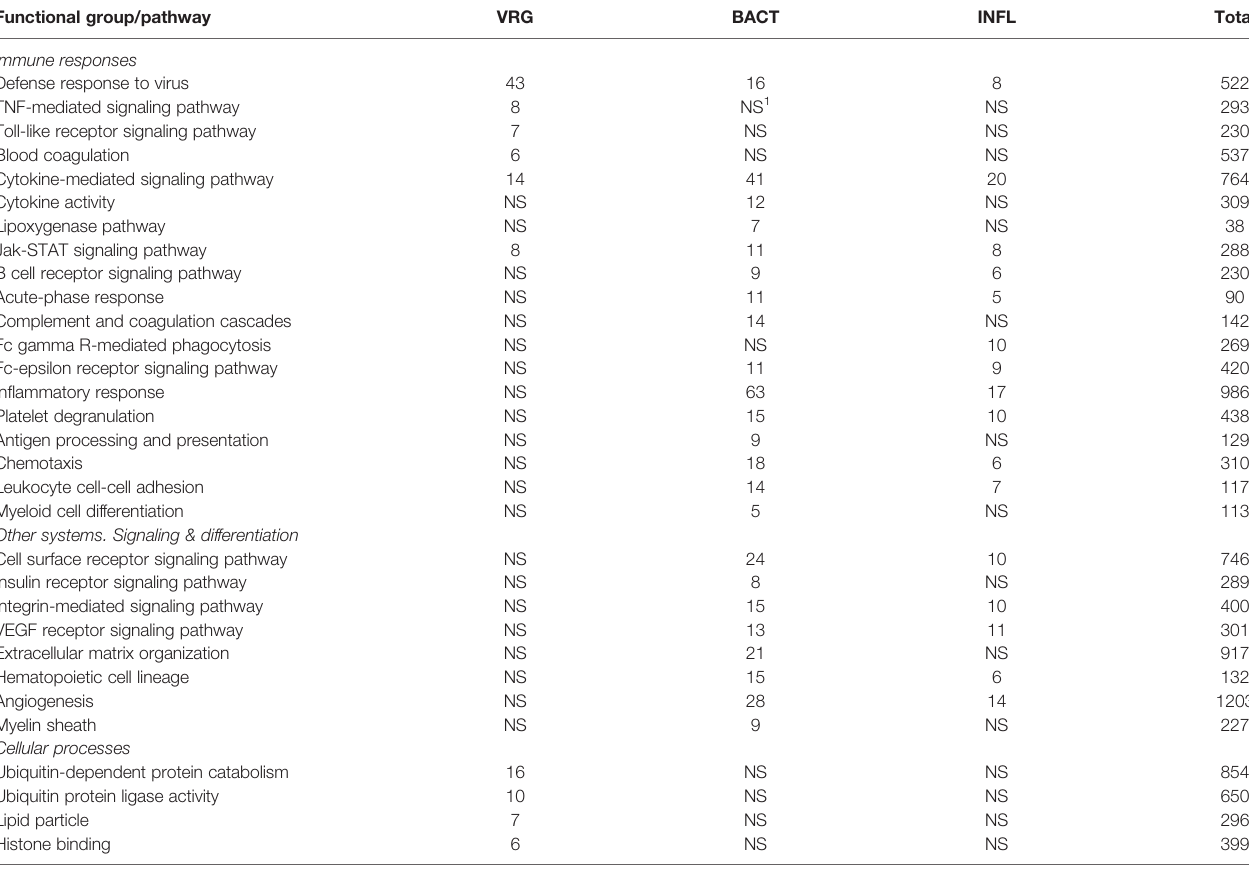
TABLE 2 | Enrichment of functional categories (GO) and pathways (KEGG). Functional